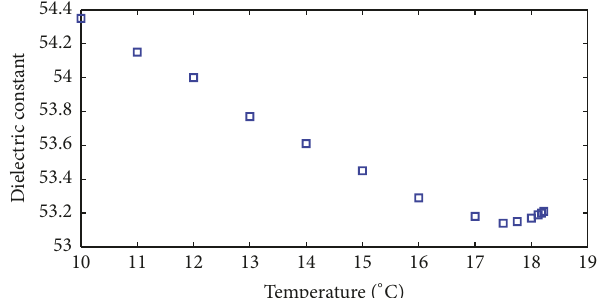
Figure 12: Temperaturedependenceof the dielectricconstant of the binary mixture at the critical composition (32.1%) obtained from [23].